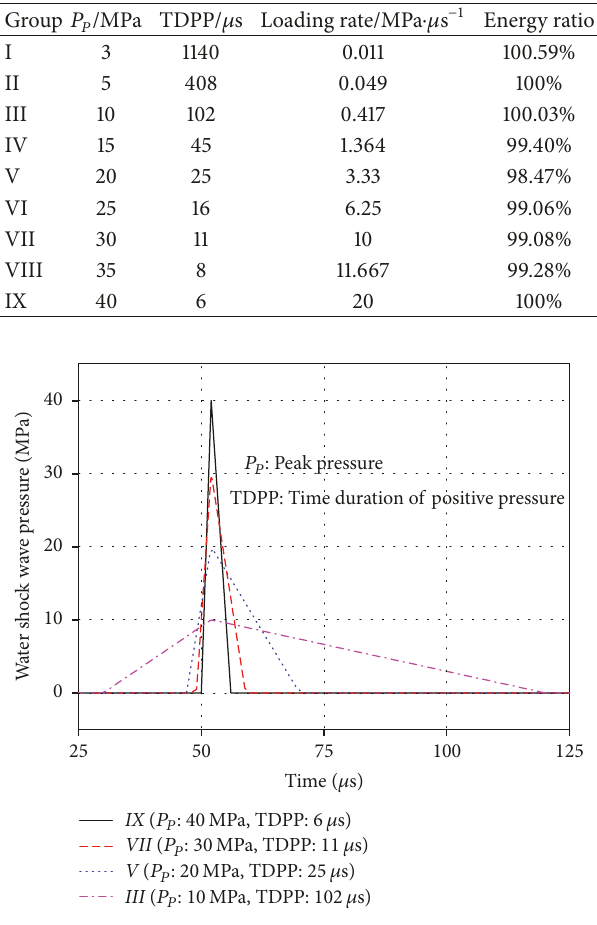
Figure 6: A part of HWSWs pressure time interval